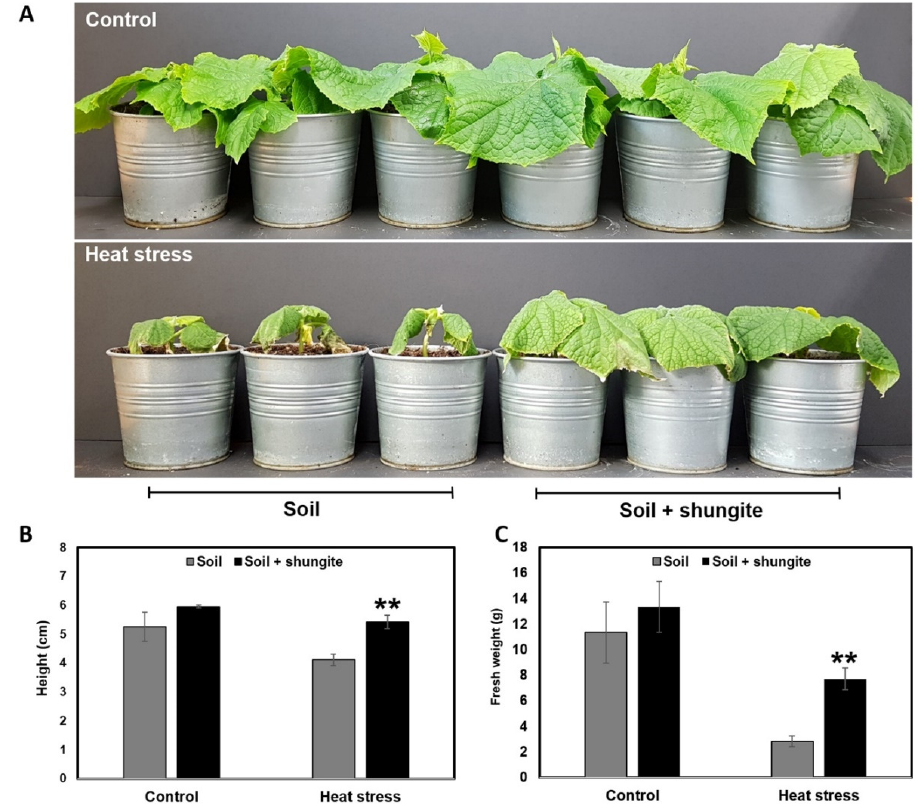
Figure 1. Effects of shungite on heat tolerance in cucumber. ( A ): Less drooping in leaves of plants exposed to shungite. Representative plants that underwent the two-step heat treatment; ( B ): Comparison of plant heights; ( C ): Comparison of fresh weight. Error bars represent mean ± standard deviation (SD), ( n = 10). Asterisks indicate statistical significance (Student’s t- test, ** p ≤ 0.05).